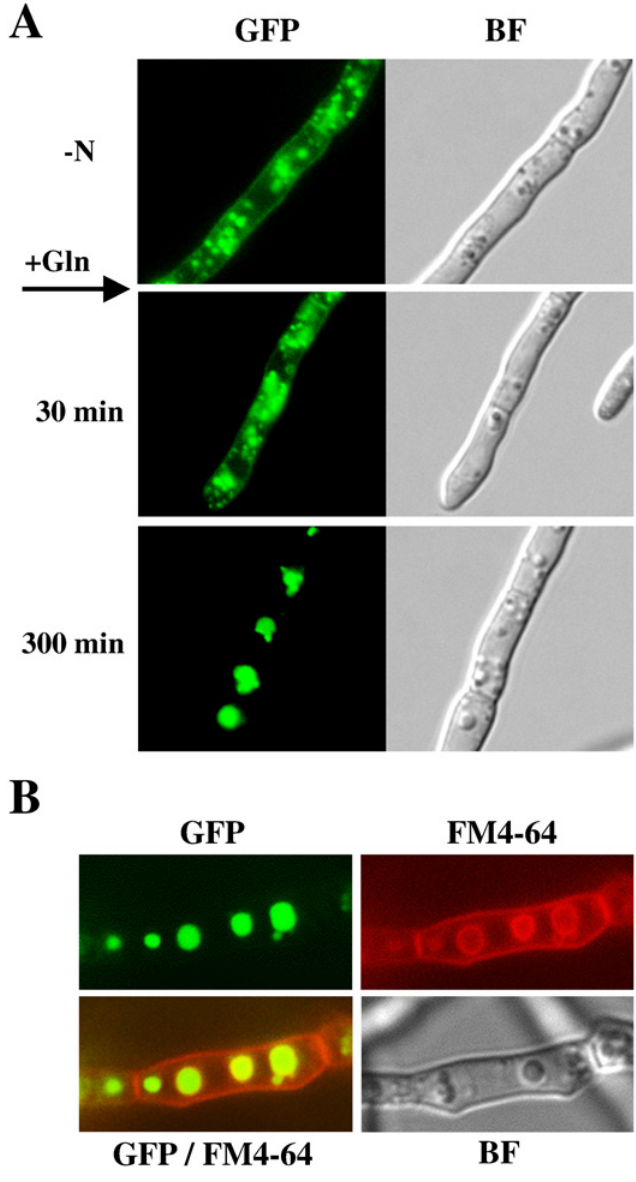
Fig 4. Subcellular localization of FfGap1 depends on nitrogen availability. F . fujikuroi wild type transformed with a FfGap1-GFP fusion construct was cultivated in liquid ICI medium with 6 mM glutamine for 48 h. (A) Cells were observed by fluorescence (GFP) and brightfield microscopy (BF) before (- N) and 30 min and 300 min after addition of 12 mM glutamine (+ Gln). (B) Cells were stained with FM4-64 and observed 60 min after addition of 12 mM Gln by fluorescence (FM4-64, GFP) and brightfield (BF)